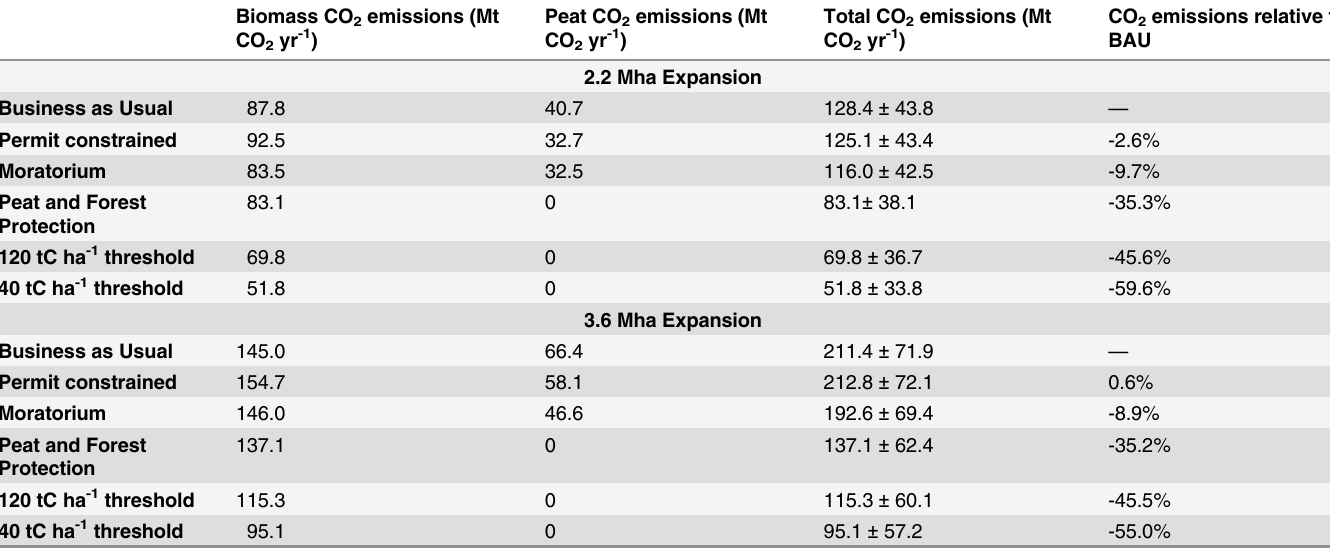
Table 2. Estimated net CO 2 emissions due to oil palm plantation establishment from 2010 –